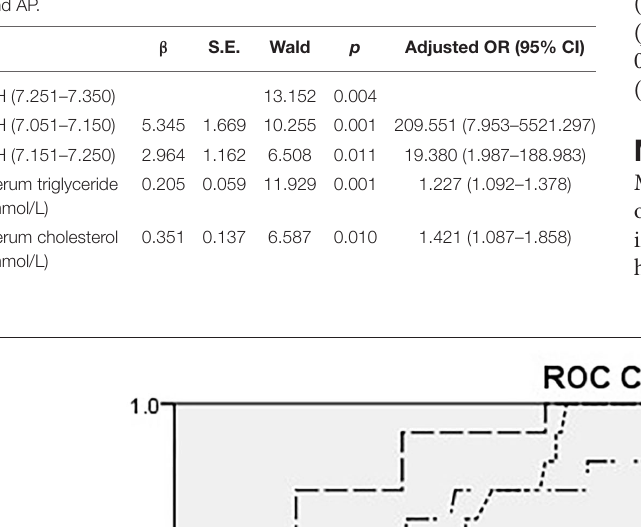
Frontiers in Medicine |